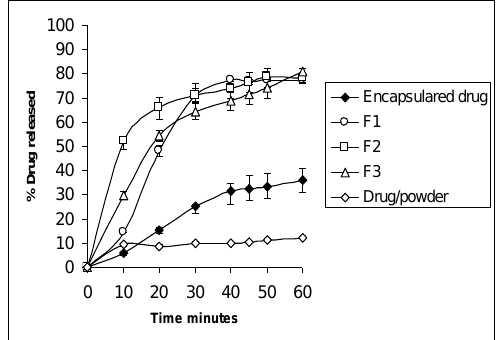
Figure 3.a : Effect of combination of SSG with starch on the dissolution of piroxicam in 0.1 N HCl at 37°C